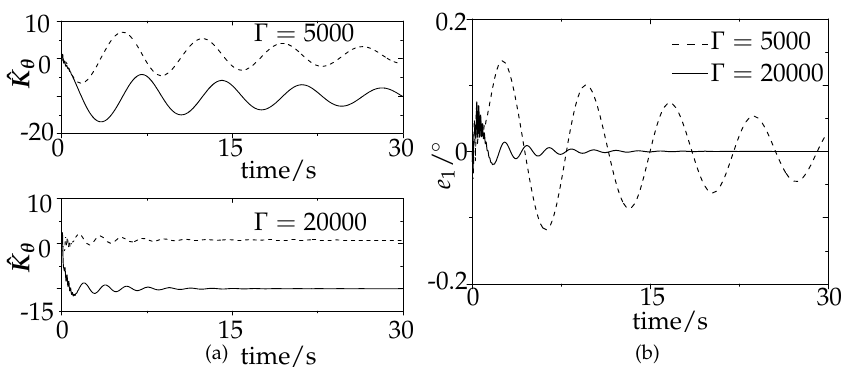
Figure 5. Simulation comparison for Γ values: ( a ) comparison of parameter K θ ; ( b ) comparison of error e 1 .